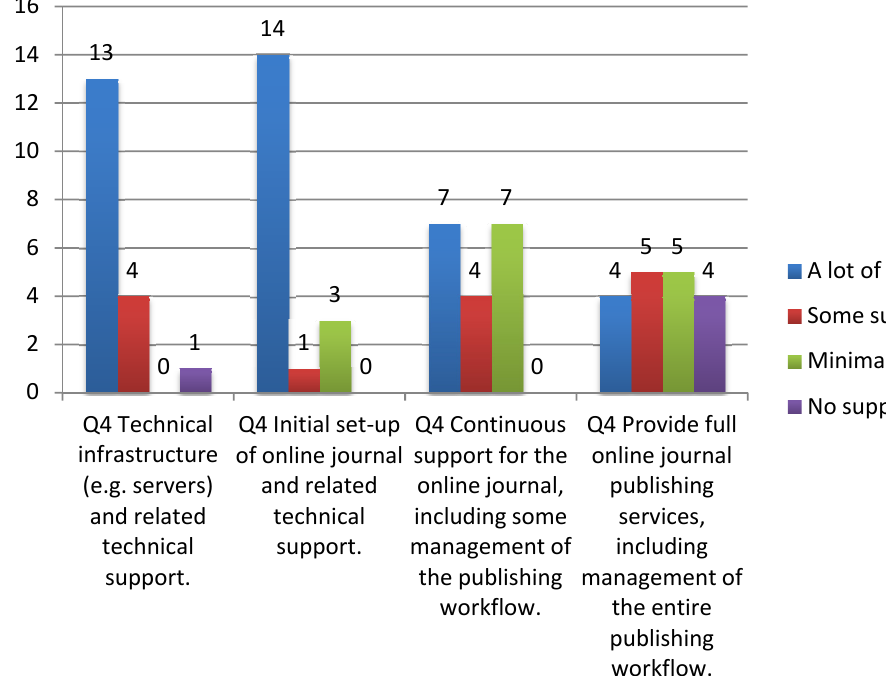
Figure 2. Amount and type of journal hosting support.